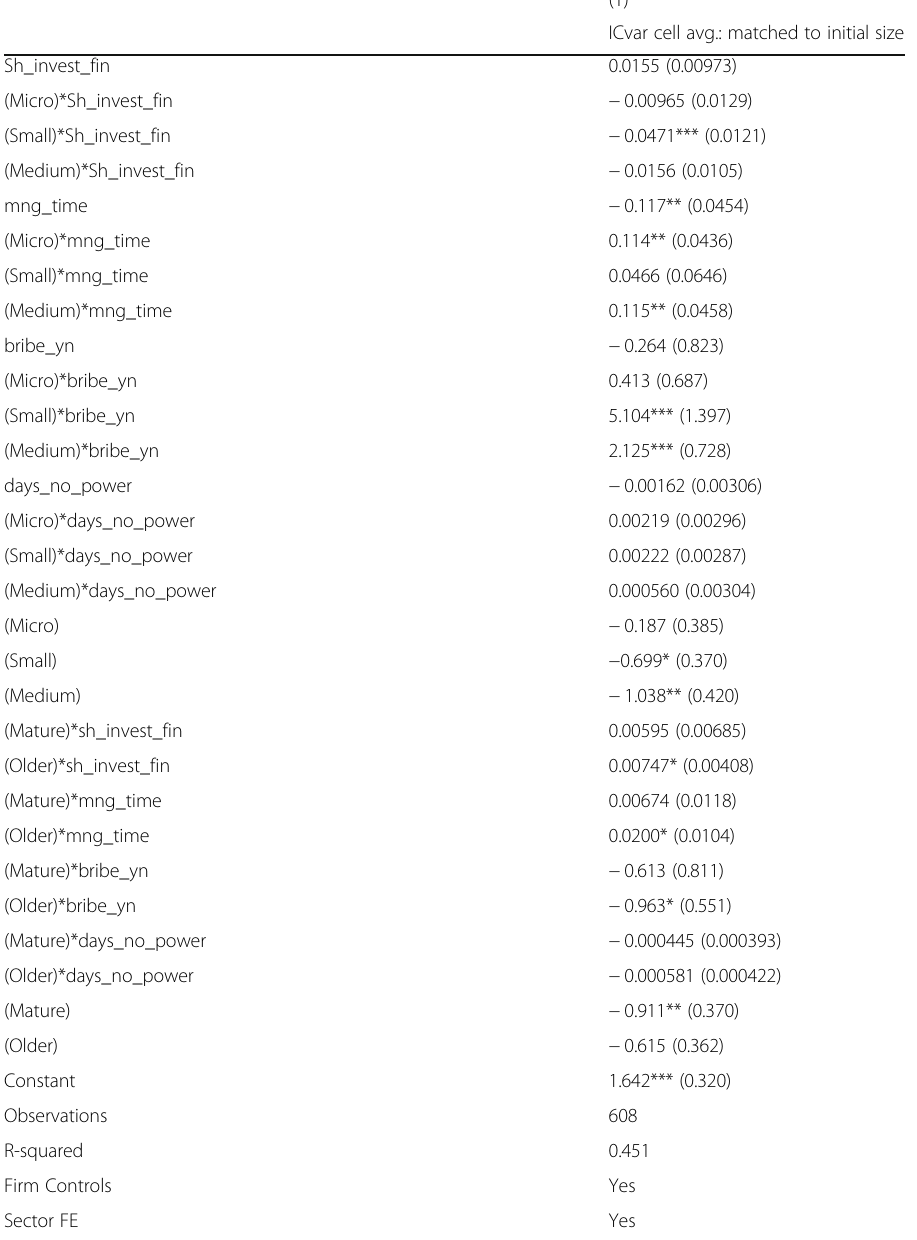
Table 8 Is it size or age that